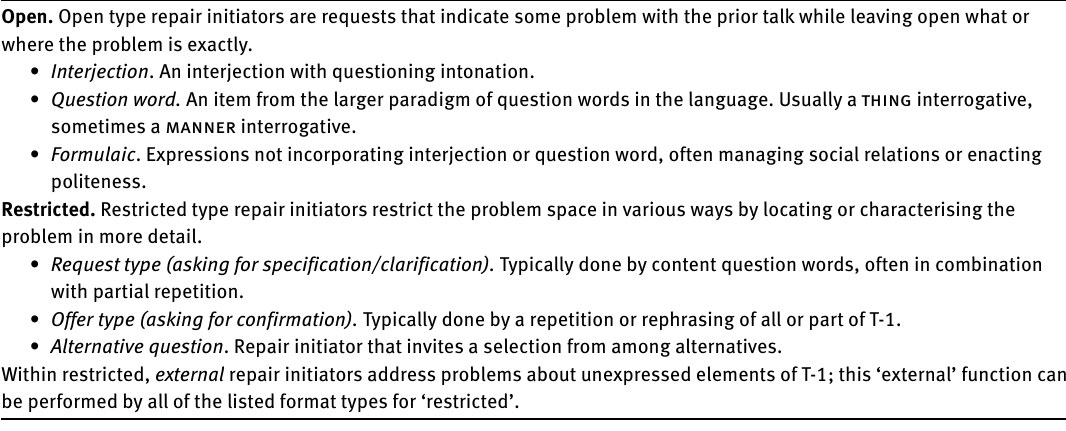
Table 2: Some basic format types for other-initiation of repair Open. Open type repair initiators are requests that indicate some problem with the prior talk while leaving open what or where the problem is exactly.